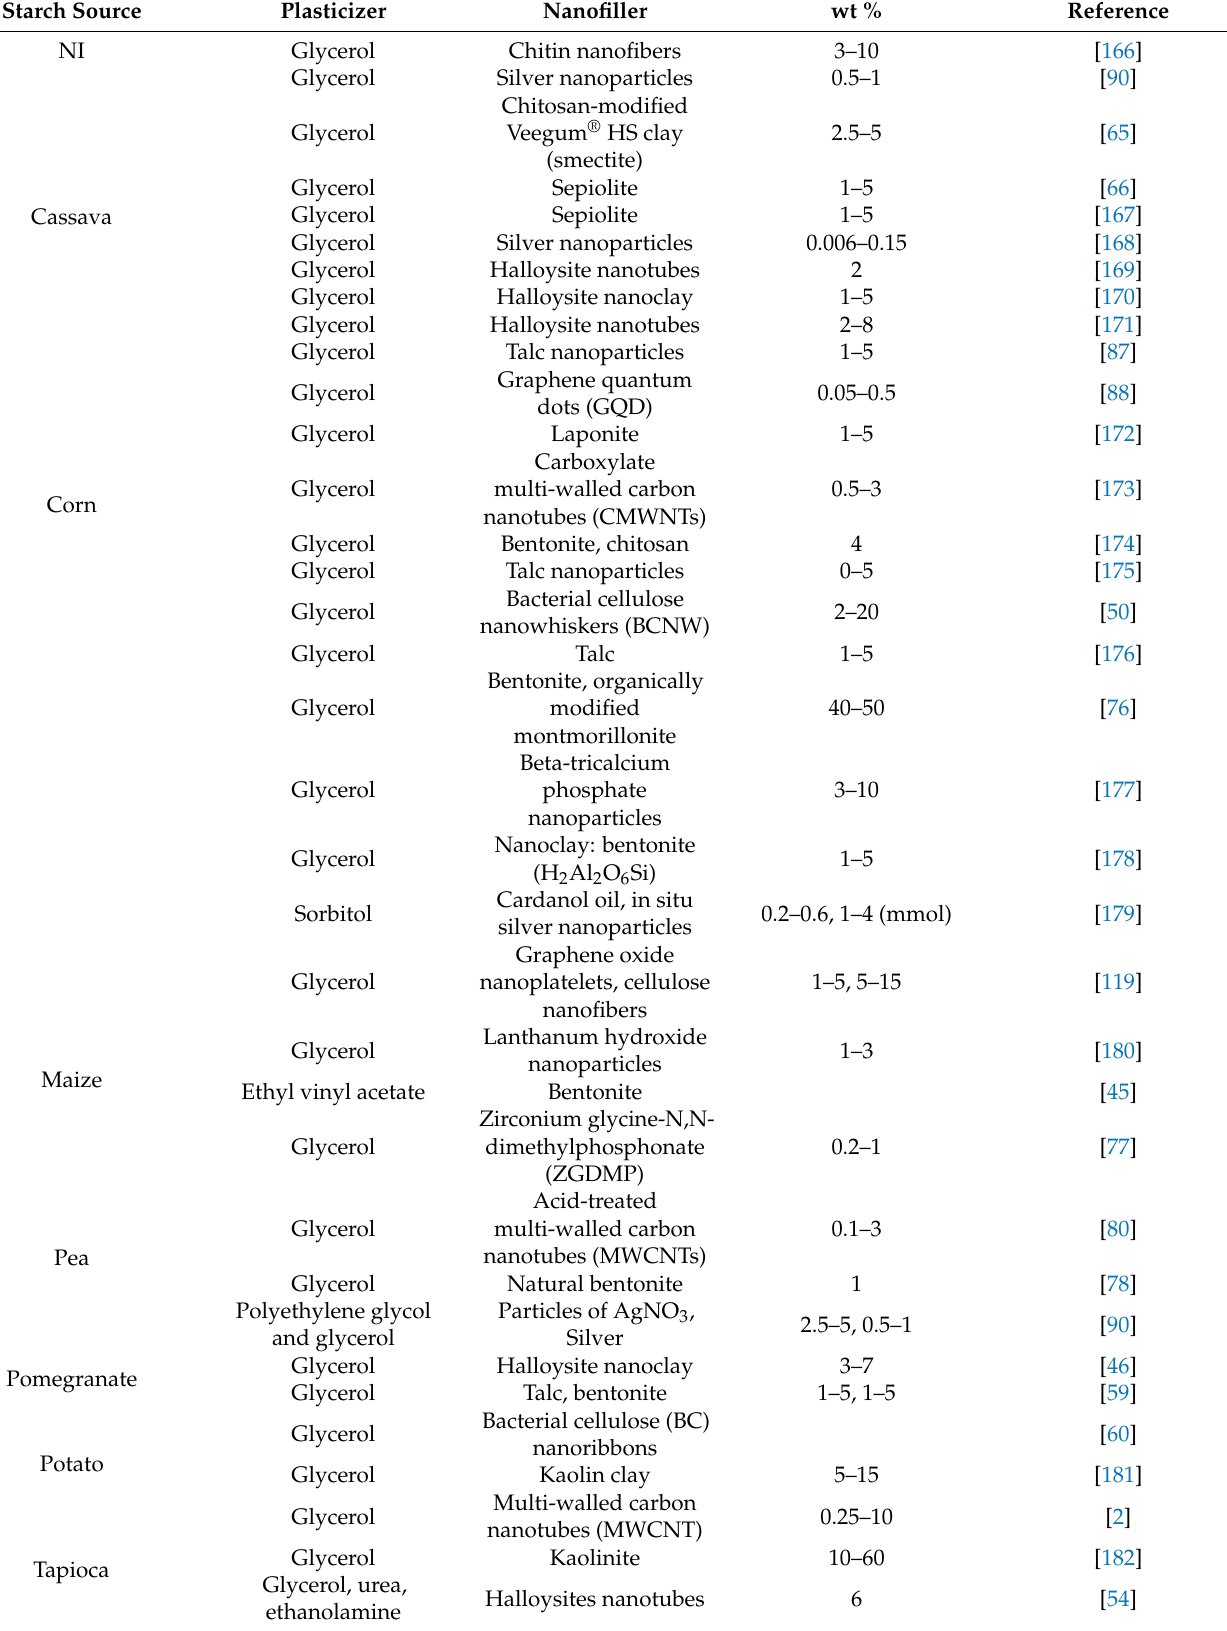
Table 5. Plasticizers and other nanofillers (including their wt %) in most used TPS